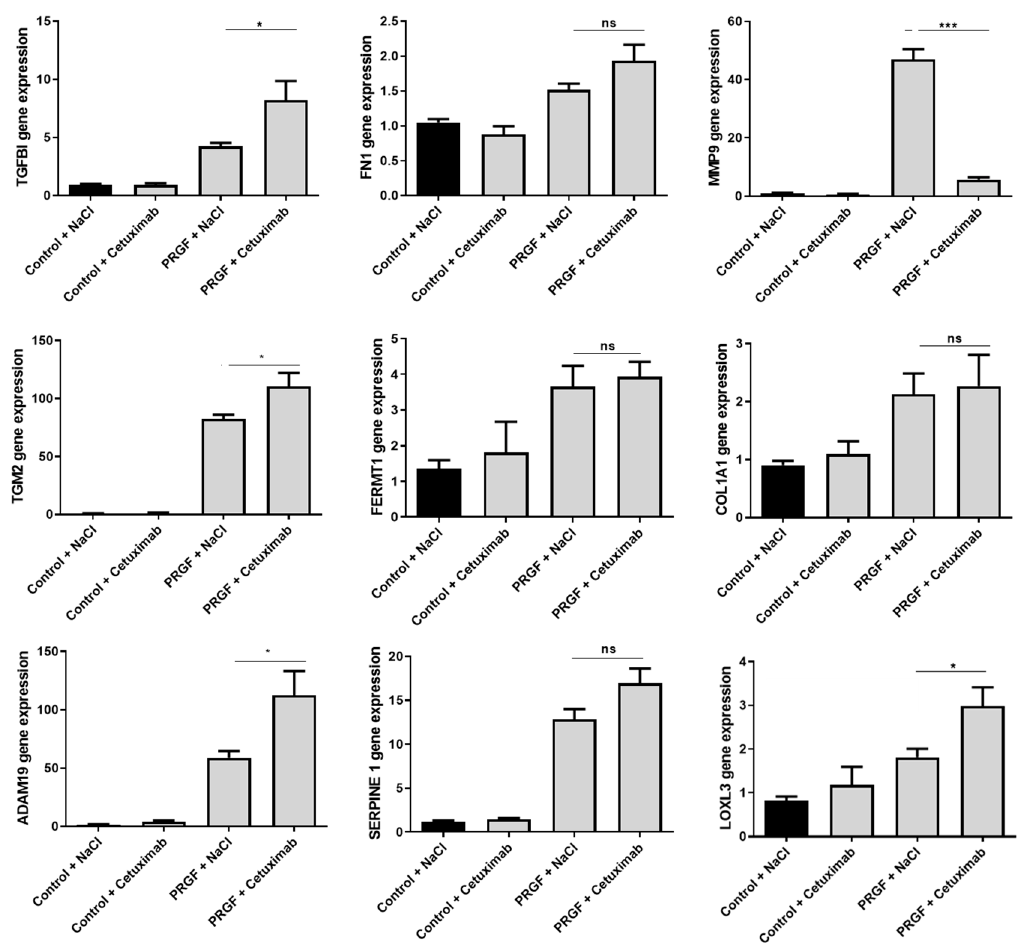
Figure 4. The EGFR influences the PRGF-induced expression of TGFBI, MMP-9, TGM2, ADAM19 and LOXL3 in human fibroblasts. Human primary fibroblasts were stimulated for 24 h with PRGF from a single donor in the presence or absence of the EGFR blocking antibody cetuximab. Relative gene expression was analyzed by real-time PCR. Shown are means ± s.e.m of three stimulations (* p < 0.05, *** p < 0.001; ns = non-significant, Student’s t -test).